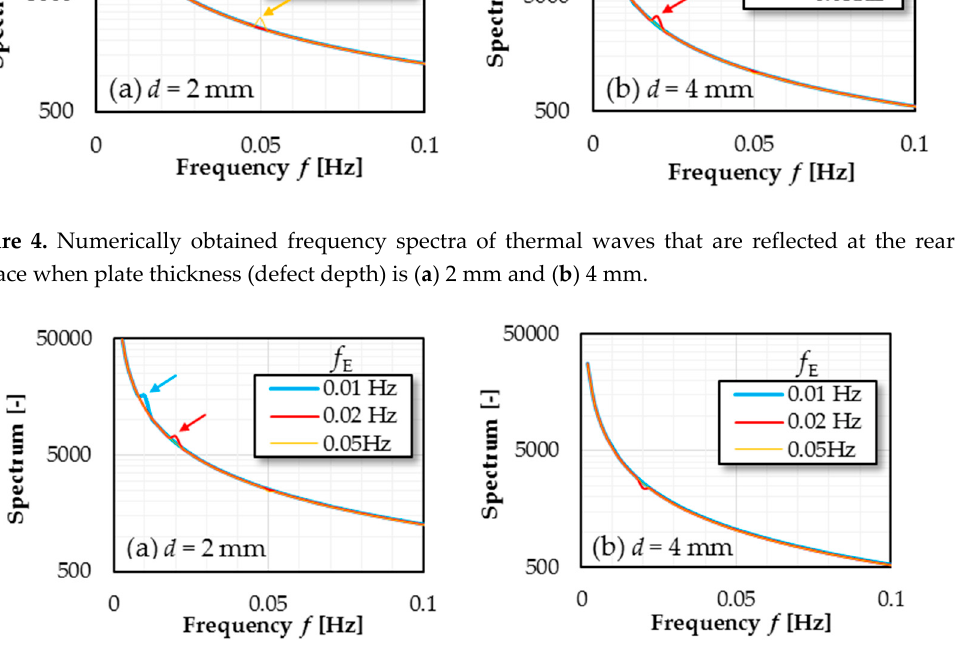
Figure 5. Numerically obtained frequency spectra of thermal waves that return to the heated surface when plate thickness (defect depth) is ( a ) 2 mm and ( b ) 4